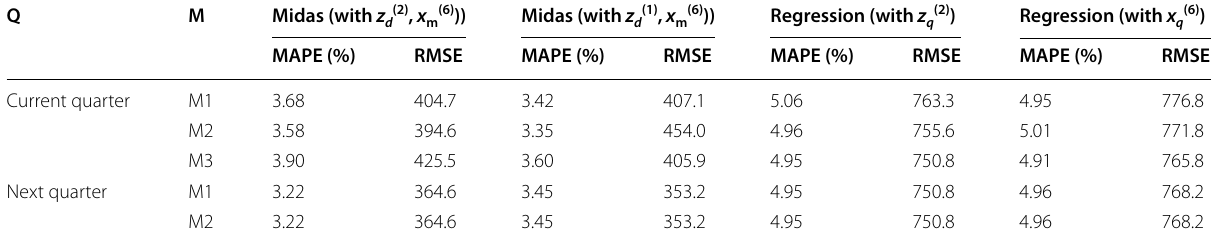
Table 14 Robustness purposes: investment model MAPE and RMSE loss